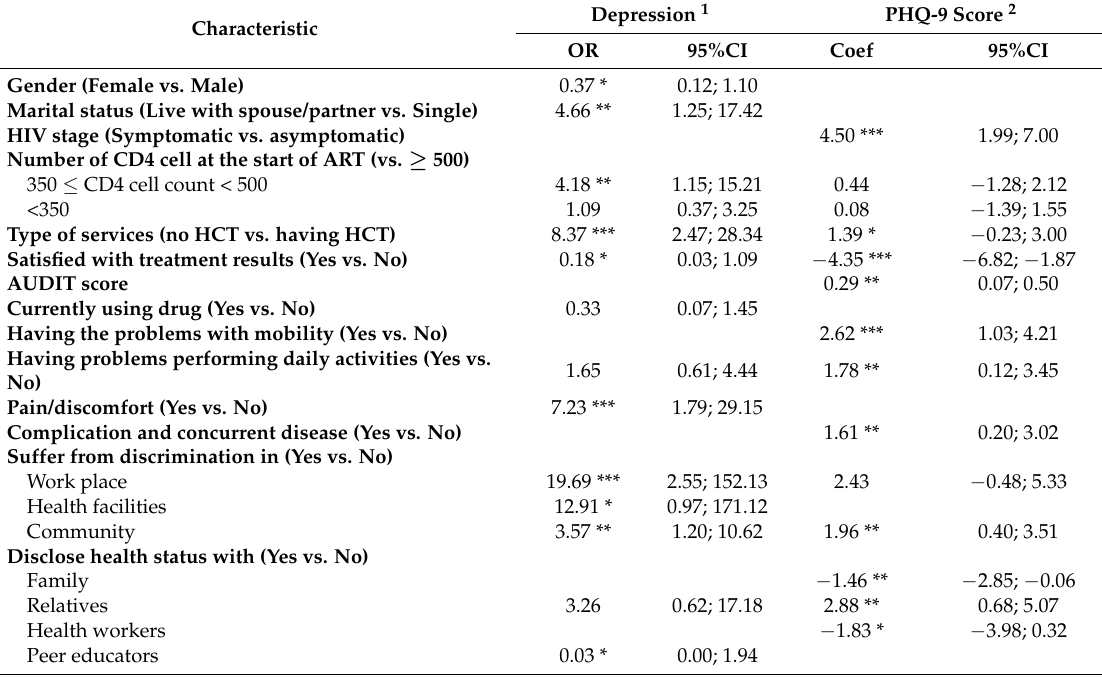
Table 6. Factors associated with depression among patients receiving ART.